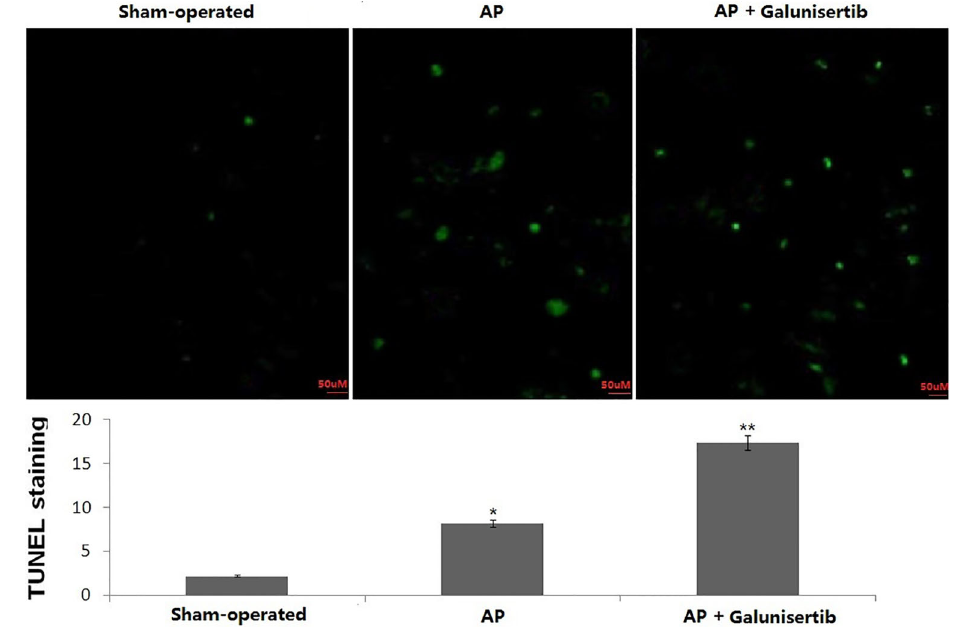
Figure 2. Photographs of TUNEL staining of the pancreatic tissues. The graph shows the average number of fl uorescence dots of images from sham-operated, acute pancreatitis (AP), and AP + galunisertib treatment groups. Results are reported as means ± SD. *P o 0.05, AP + galunisertib vs AP and **P o 0.01, AP + galunisertib vs sham-operated (Student ’ s t